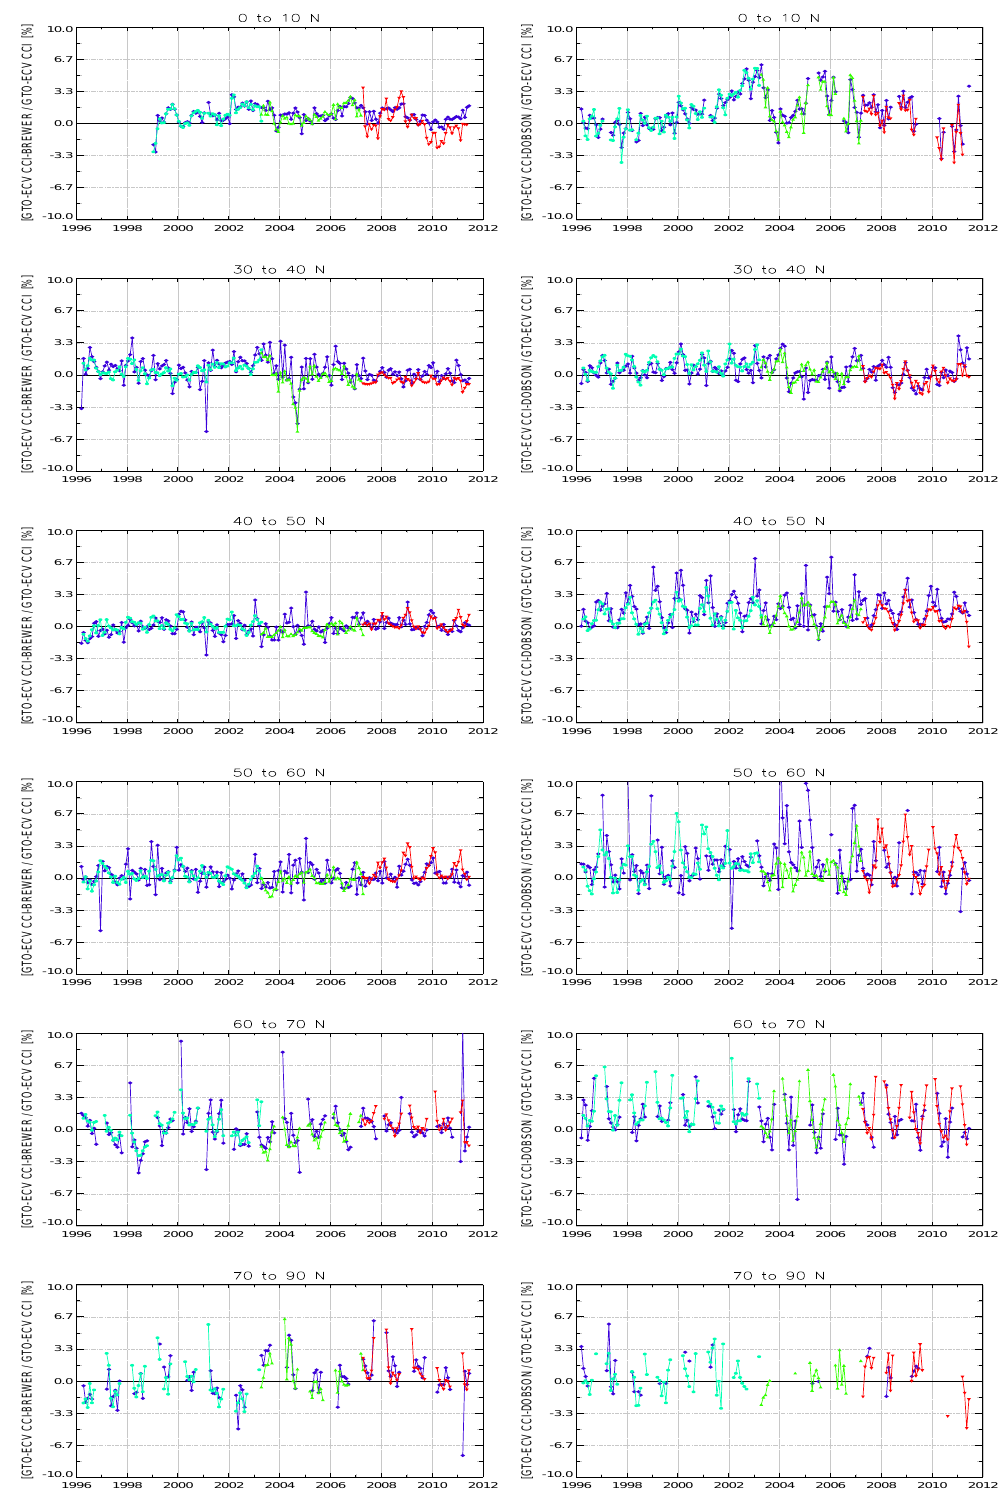
Figure 10. Percentage difference between satellite data records and ground-based data as a function of time for the Northern Hemisphere for six zonal belts 0–10, 30–40, 40–50, 50–60, 60–70, and 70–90 ◦ N from top to bottom. Left column: Brewer comparisons and right column: Dobson comparisons. Level 3 comparison in dark blue, GOME level 2 comparison in light blue, SCIAMACHY in green, and GOME-2A in